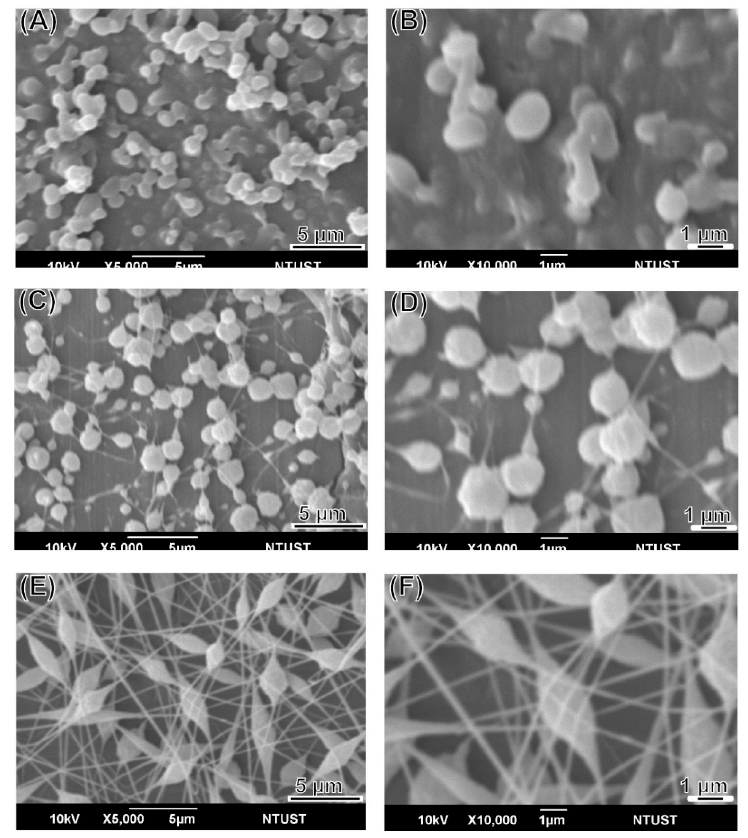
Figure 2. SEM images of particles produced from a series of 10 wt% stock solutions containing the different ratio of PVP and PMMA: ( a , b ) 8:2, ( c , d ) 5:5 and ( e , f ) 2:8 (PVP:PMMA; w/w).